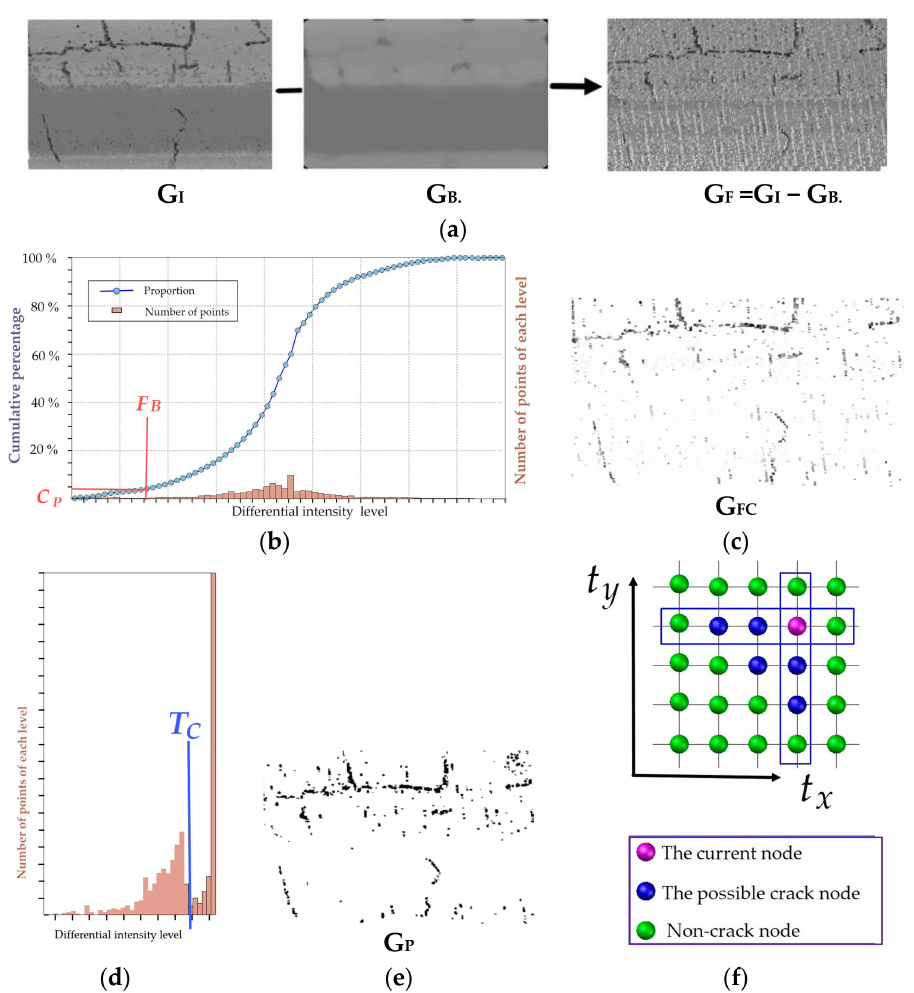
Figure 8. The flow of detection of the low-intensity points with height no higher than the road surface. ( a ) The background-di ff erential map (G F ), ( b ) the relevant truncation value ( F B ) by the given proportion of cracks’ point ( T P ), ( c ) the di ff erential truncation map (G FC ), ( d ) the segment threshold, T C , of the possible cracks, ( e ) the binary map of possible crack candidates (G P ), and ( f ) the filter about valley e ff